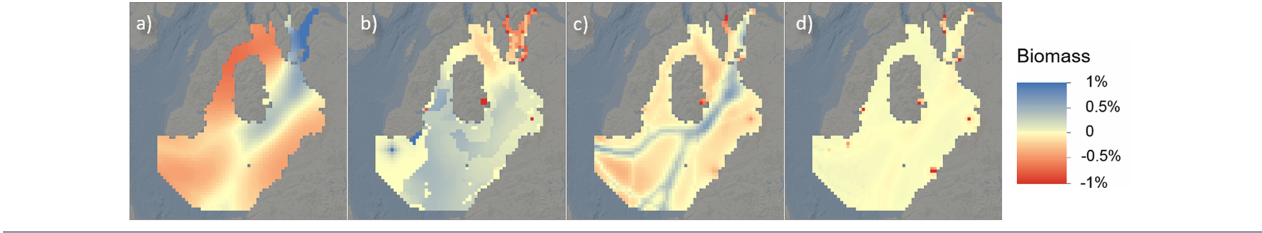
Fig. 9. Firth of Clyde biomass distribution and intensity changes up to 1% in response to the introduction of marine spatial planning start-up pressures after a 40-yr simulation period for various compartments.